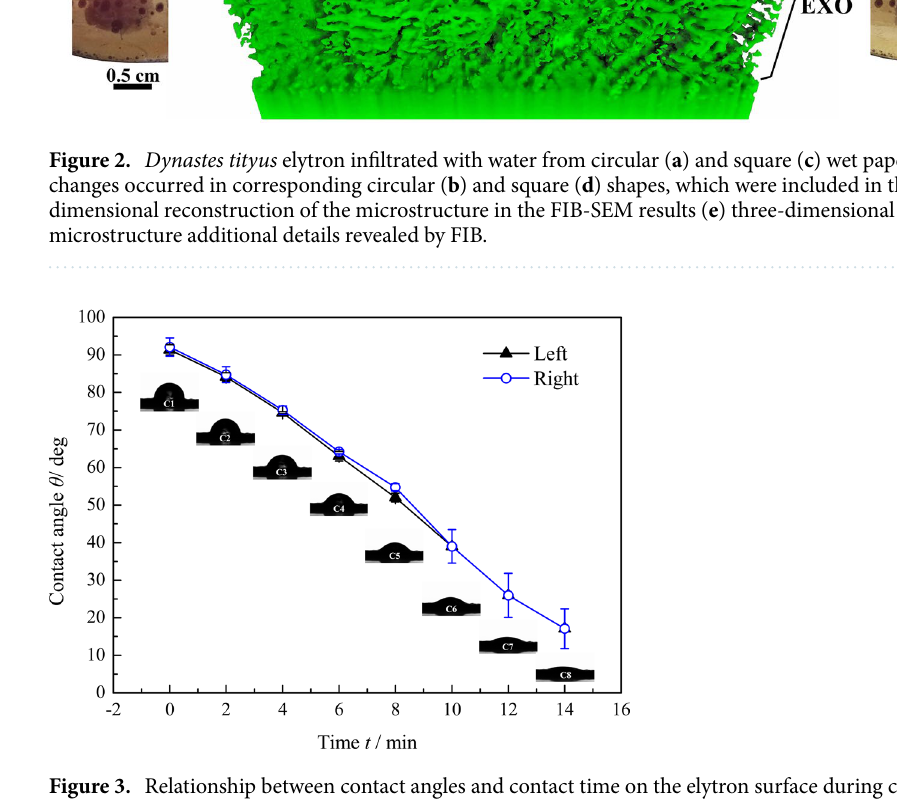
Figure 3. Relationship between contact angles and contact time on the elytron surface during contact angle